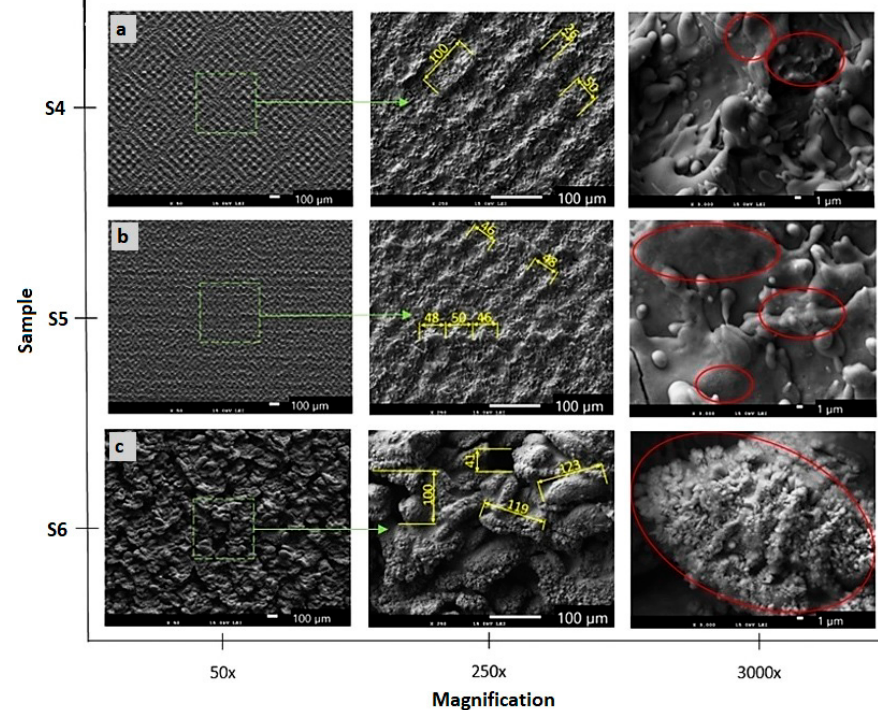
Figure 5. SEM micrographs (original magnifications of 50 × , 250 × and 3000 × ) of the machined surfaces. ( a ) surface S4 (E T = 12.5 mJ; ( b ) surface S5 (E T = 25 mJ); ( c ) surface S6 (E T = 500 mJ). Areas containing oxides are indicated in red.